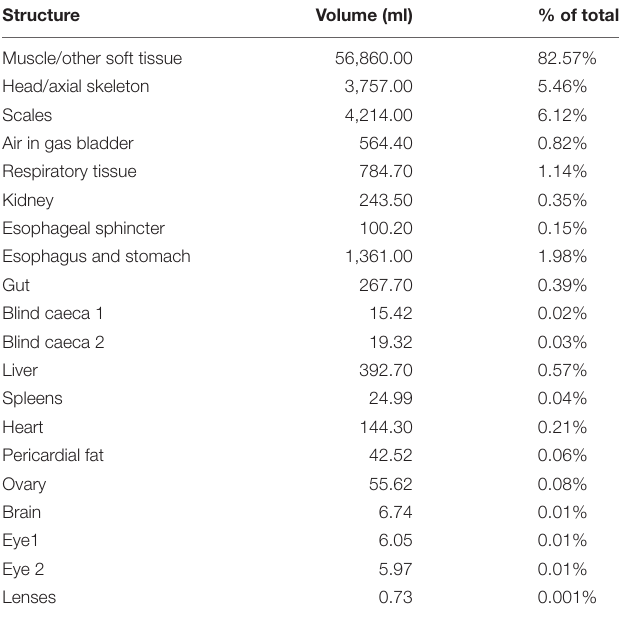
TABLE 1 | Body structure volumes in milliliters (ml) and as percent of whole fish.